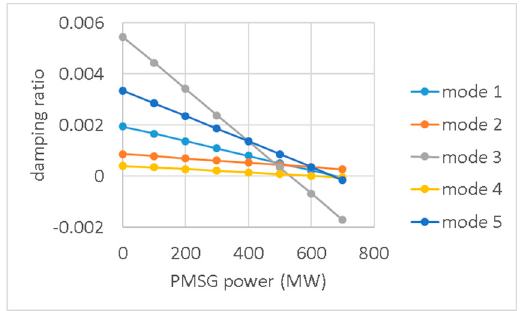
Figure 13. Damping ratios of torsional modes for the integration of the PMSG wind